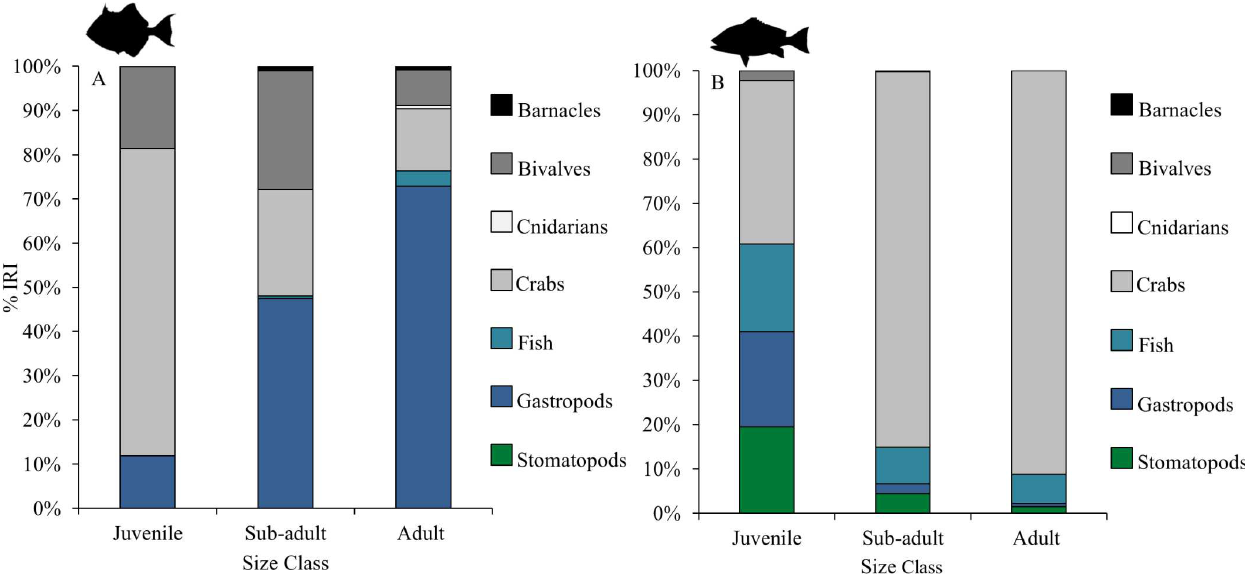
Fig 2. Percent index of relative importance (%IRI) for gray triggerfish and red snapper by size class. Prey groups shown are those accounting for more than 1% of the total percent weight (%W) in the gut contents. (A) Shows the %IRI for juvenile (n = 13), sub-adult (n = 44), and adult (n = 32) gray triggerfish gut contents, while (B) shows the %IRI for juvenile (n = 52), sub-adult (n = 44), and adult (n = 32) red snapper gut contents. https://doi.org/10.1371/journal.pone.0203873.g002 Analysis of gray triggerfish and red snapper gut contents indicated differences in primary prey groups among regions (Table 2). Gray triggerfish gut contents in the east region signifi- cantly differed from those in the central and west regions (p < 0.01, PERMANOVA). This was Table 3. Contribution estimates from the diet mixture models for each size class, species, and region. Size Class Region Prey